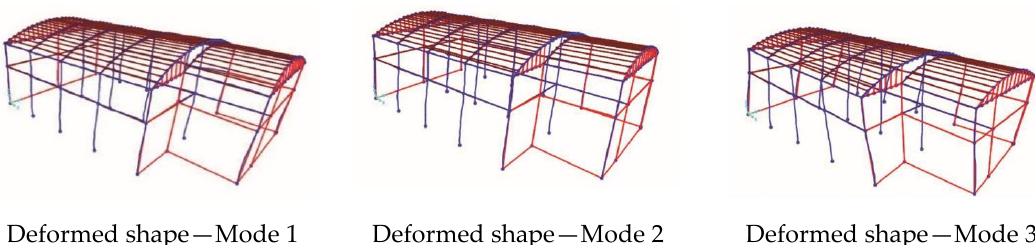
Figure 19. Modes of vibration of the FE model of Structure A. Table 4. Numerical frequencies (f) and mode shape types obtained from the FE model—Structure A.